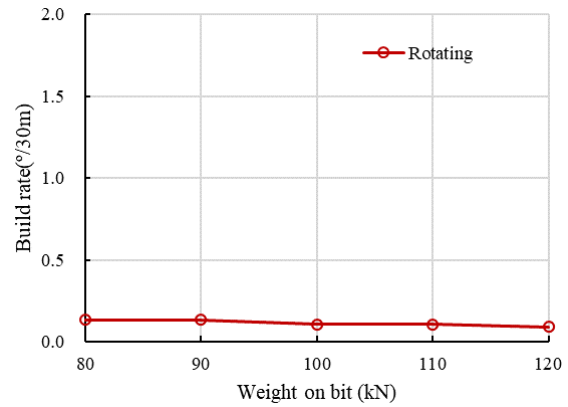
Fig. 23. Rotating build rate VS outer diameter of lower stabilizer